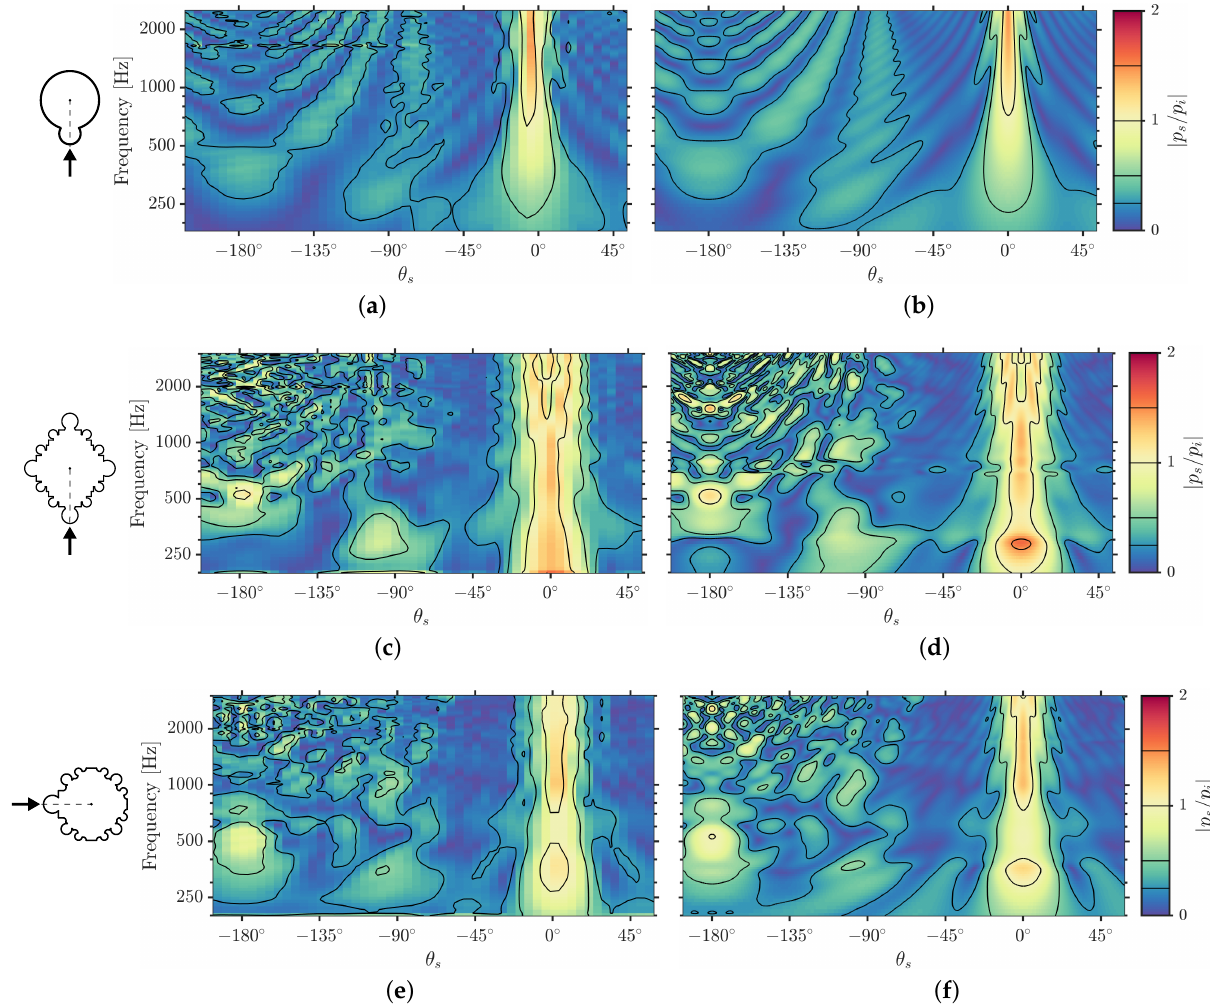
Figure 7. | p s / p i | for N1 with θ 0 = 90° ( a , b ), T with θ 0 = 90° ( c , d ), and Ch with θ 0 = 0° ( e , f ). Scale model measurements ( left ) compared to simulations ( right ). The frequency axis of the measurements is scaled according to the factors given in Table